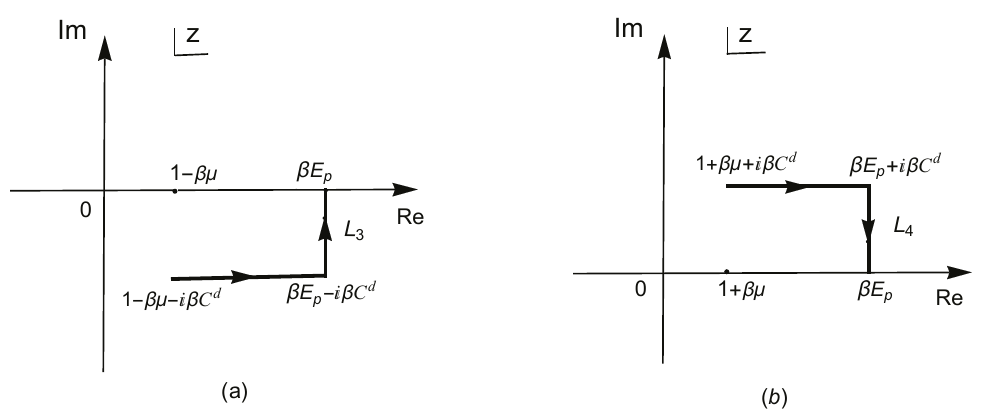
Figure 4 . Integration paths for the fermionic